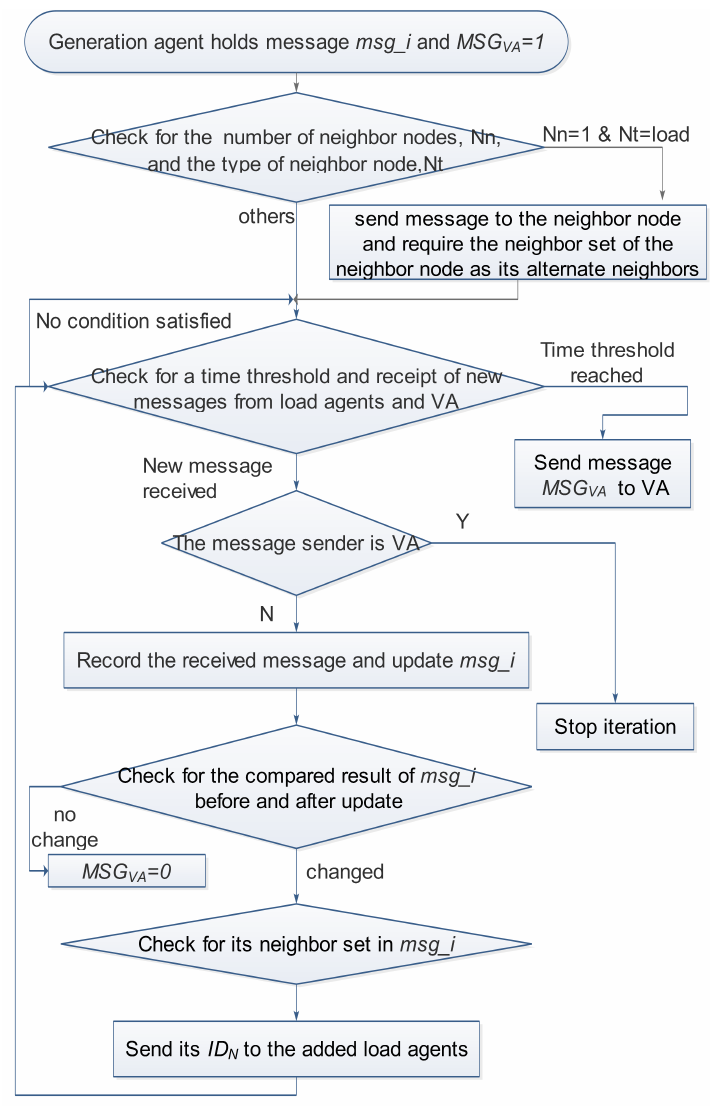
Figure 2. Flow chart of simplifying network.